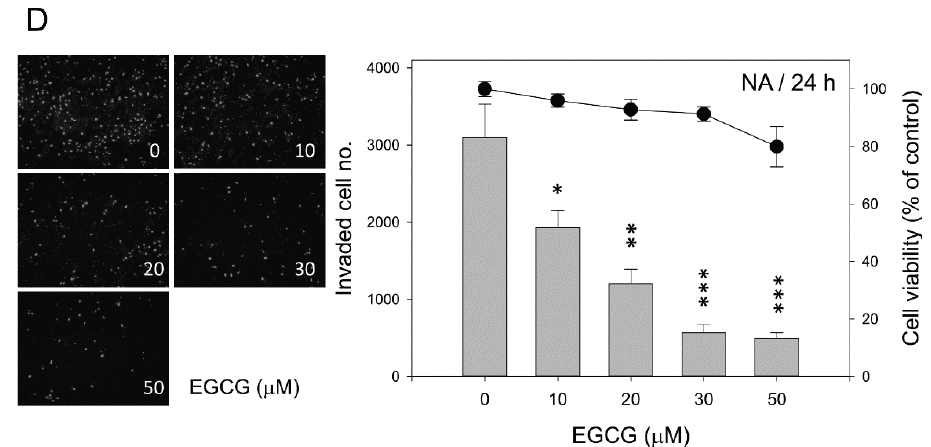
Figure 2. EGCG inhibits the migration and invasiveness of NPC cells. Cells were treated with various concentrations of EGCG for the times indicated. ( A , B ) The migration of TW01 and NA cells was determined by the number of cells that had migrated into the central blank area at 48 h ( left panel ). The bar plots represent the number of migrated cells and the line and dot plot indicates the viability of cells ( right panel , the viability data were derived from the data of Figure 1C by defining the mock group as 100% at 48 h). Data indicate the average value of triplicates (mean ± SD). **: p < 0.01; ***: p < 0.001, compared to the mock-treated cells; ( C , D ) The invasiveness of TW01 and NA cells was determined by the number of cells that had invaded and transmigrated to the lower surface of the transwell membrane at 24 h ( left panel ). The bar plots represent the number of invading cells and the line and dot plot indicates the viability of cells ( right panel , the viability data were derived from the data of Figure 1C by defining the mock group as 100% at 24 h). Data indicate the average value of triplicates (mean ± SD). *: p < 0.05; **: p < 0.01; ***: p < 0.001, compared to the mock-treated